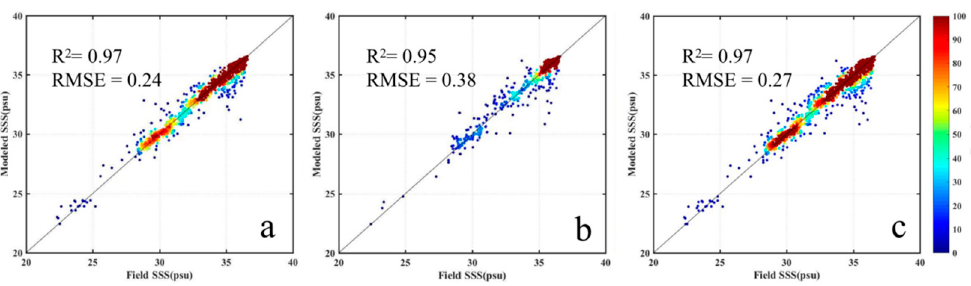
Figure 4. Cubist model performance in estimating SSS in both training ( a ), validation ( b ) and total dataset ( c ); data pairs are color coded by data density.